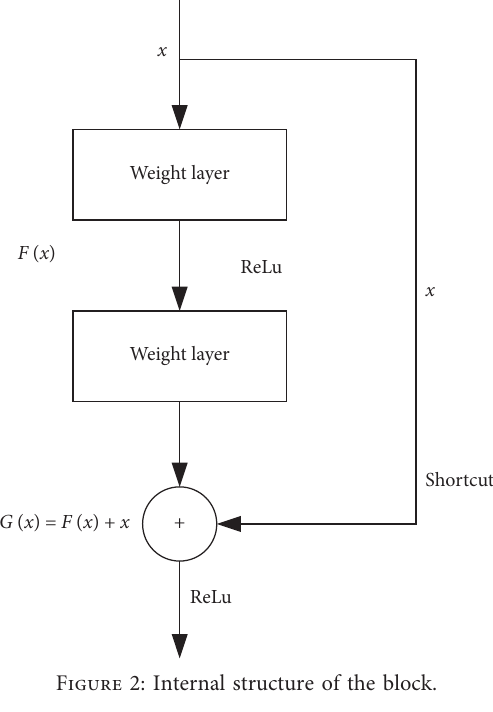
Figure 2: Internal structure of the